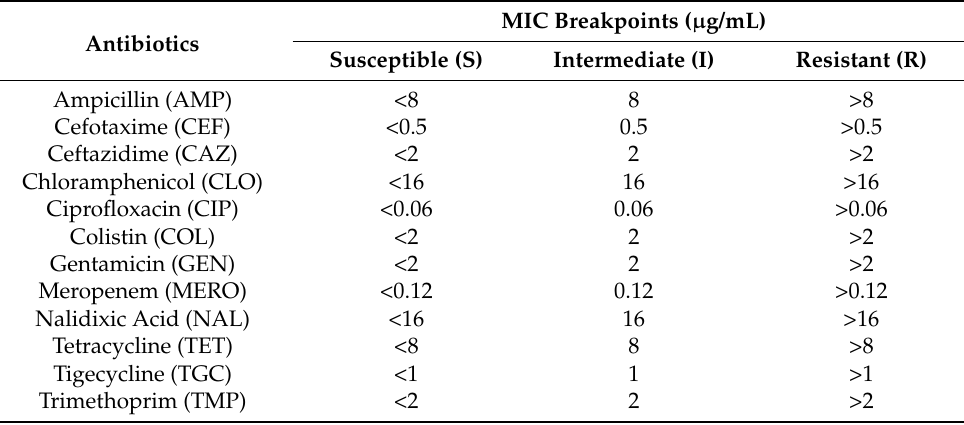
Table 5. EUCAST breakpoint tables for interpretation of MICs of